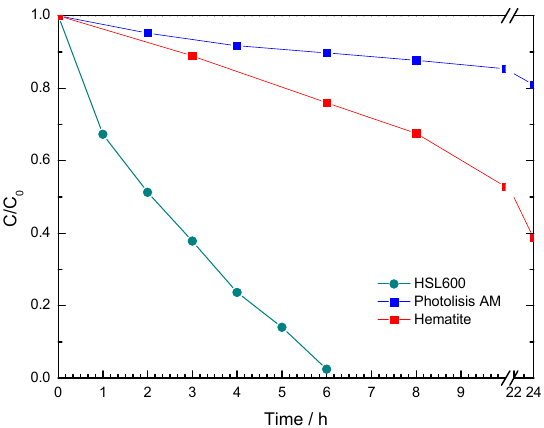
Figure 6. Methylene Blue photochemical degradation by photolysis, α Fe 2 O 3 and HSL600 samples.